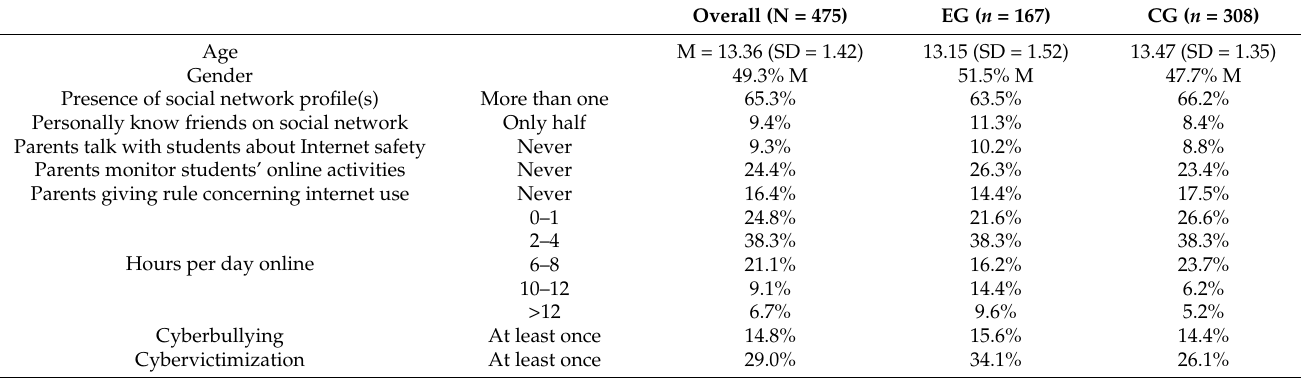
Table 2. Descriptive statistics of the